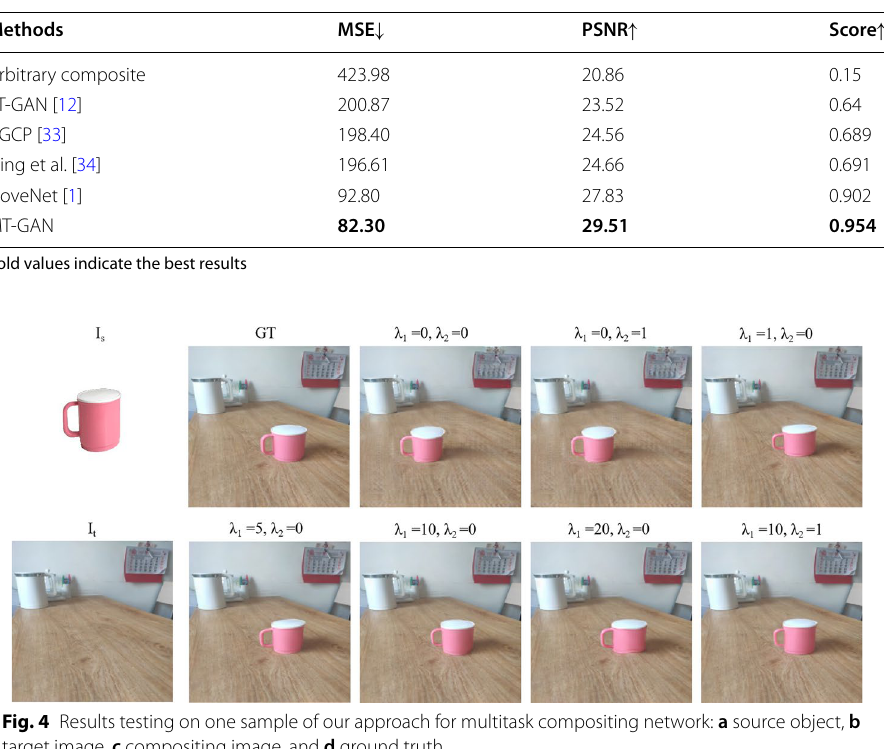
Table 2 Result comparison with other deep learning‑based methods for multitask image compositing on SHU dataset